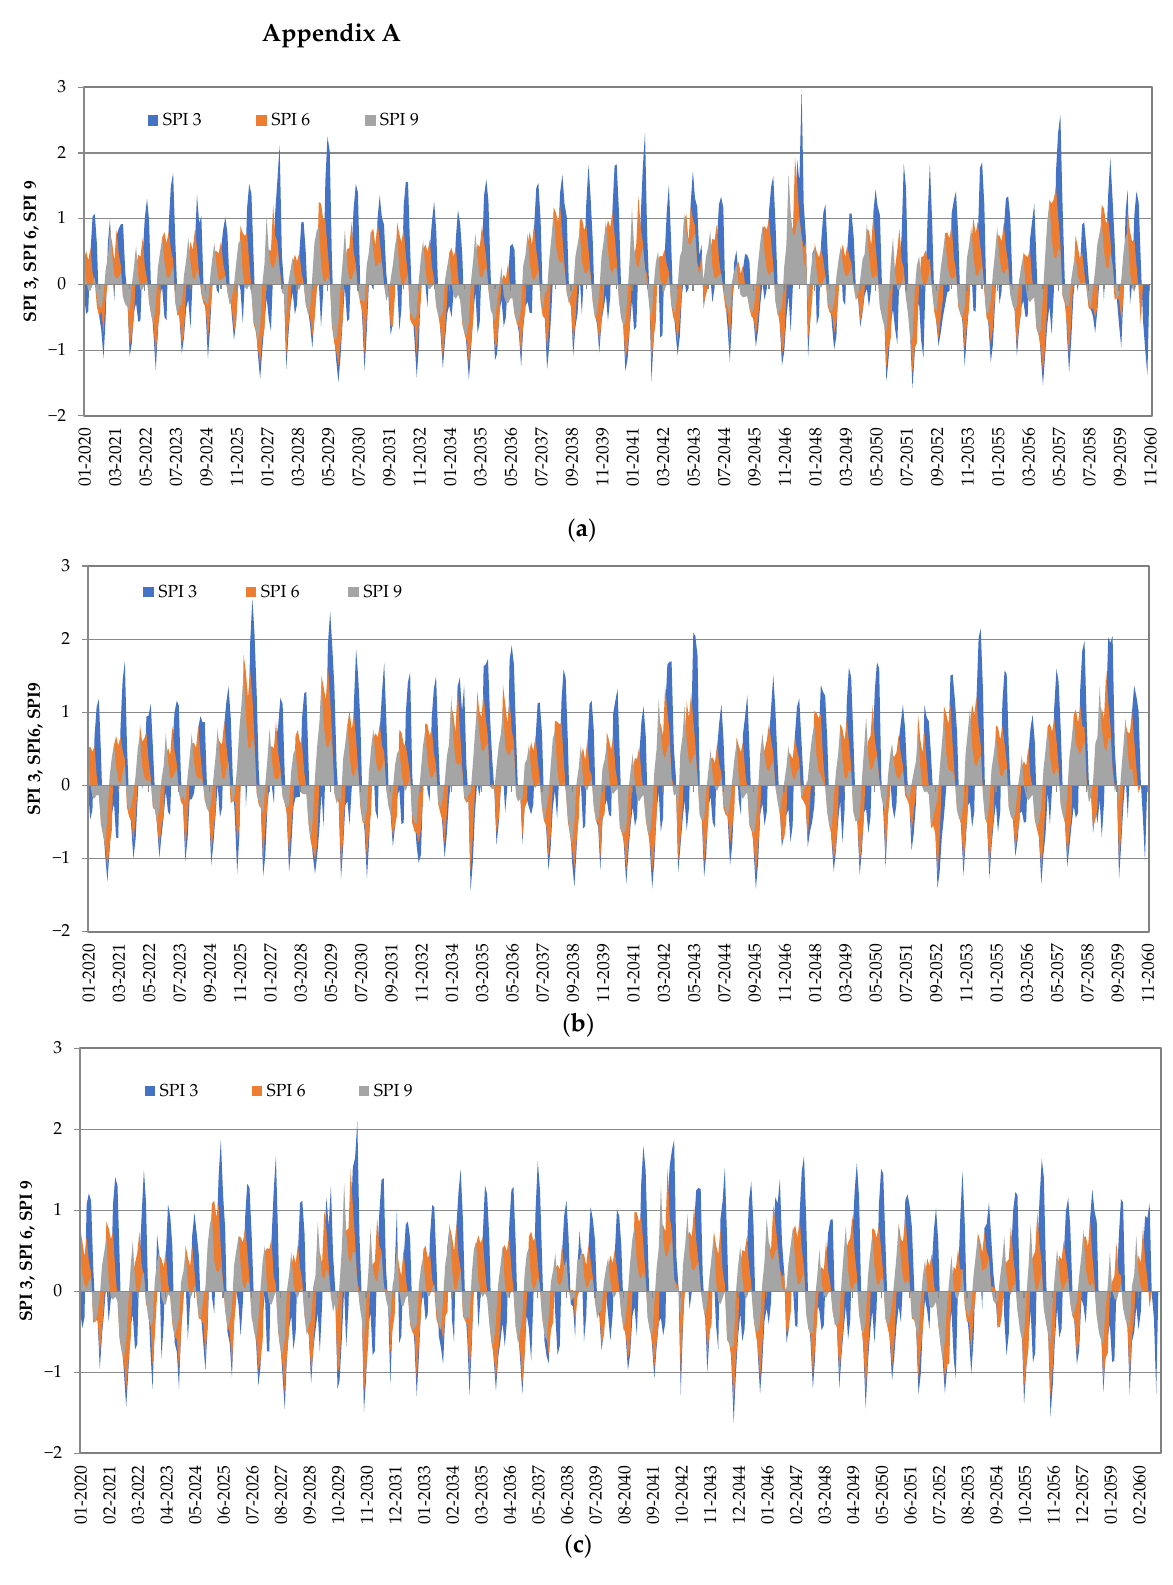
Figure A1. Different time series (SPI 3, SPI 6, SPI 9) for monthly drought patterns at Tri Ton meteorological station using various climate change scenarios, SSPI 2.6 ( a ), SSP2 4.5 ( b ), and SSP5 8.5 ( c ). Table A1. Number of occurrences of drought and humidity in the different patterns of SPI using climate change data at Tri Ton station.